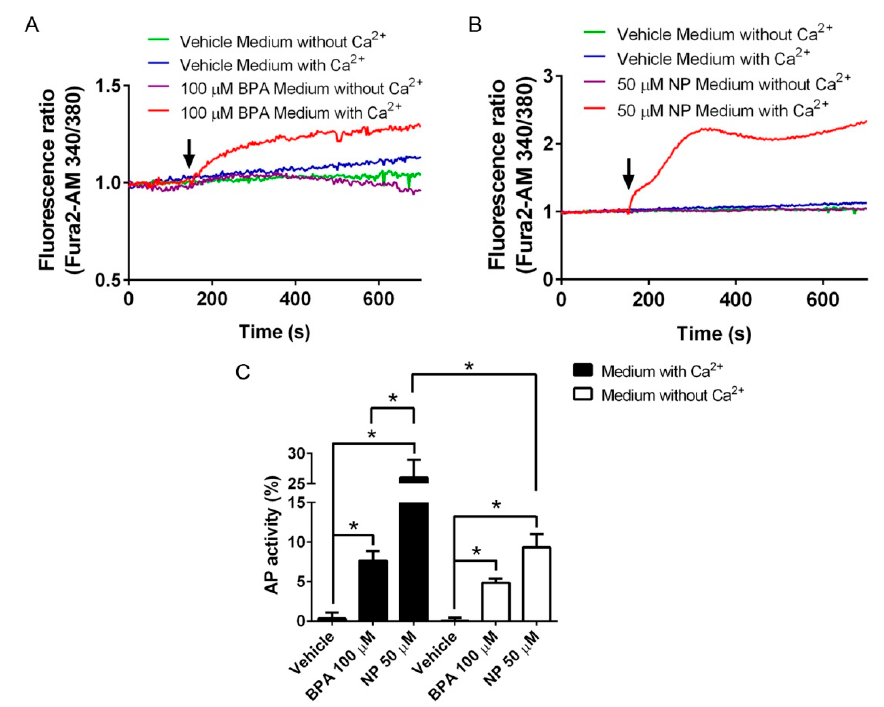
Figure 5. Participation of calcium (Ca 2+ ) on the sheddase activity induced by BPA and NP in LNCaP cells. Intracellular Ca 2+ levels after 100 μ M BPA ( A ) or 50 μ M NP ( B ) treatment in a medium with or without Ca 2+ . ( C ) Shedding of NRG1 in (AP)-NRG1 transfected LNCaP cells, when they are incubated for 3 h in the presence of 100 μ M BPA or 50 μ M NP, in a medium with (black bars) or without (white bars) Ca 2+ . Mean ± SEM, * p < 0.05, n = 5.